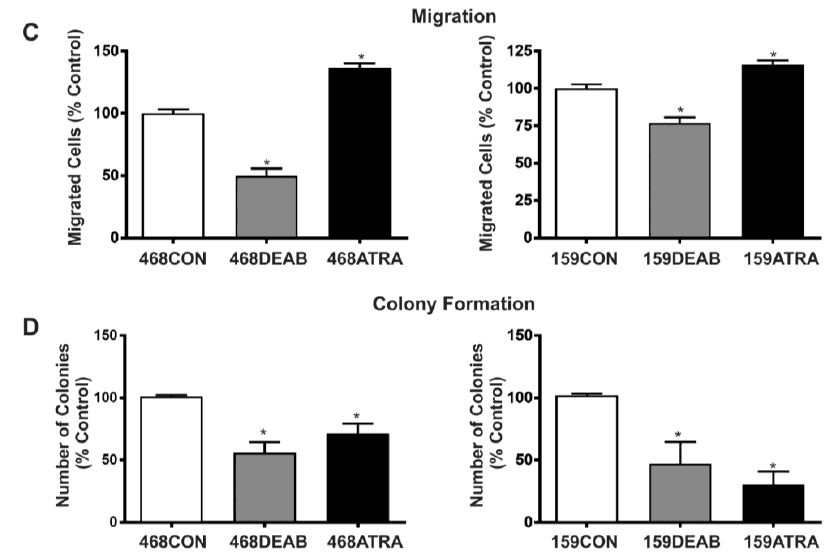
Figure 1. Treatment with diethylaminobenzaldehyde (DEAB) reduces breast cancer cell ( A ) proliferation, ( B ) adhesion, ( C ) migration, and ( D ) colony formation in vitro. MDA-MB-468 (left panels) and SUM159 (right panels) human breast cancer cells were treated with 5 μM all- trans retinoic acid (ATRA), 100 μM DEAB or ethanol (EtOH) as a vehicle control (CON). In all cases, data represents the mean ± standard error of the mean (SEM) normalized to vehicle control. * = significantly different than respective vehicle control treatment ( p < 0.05).